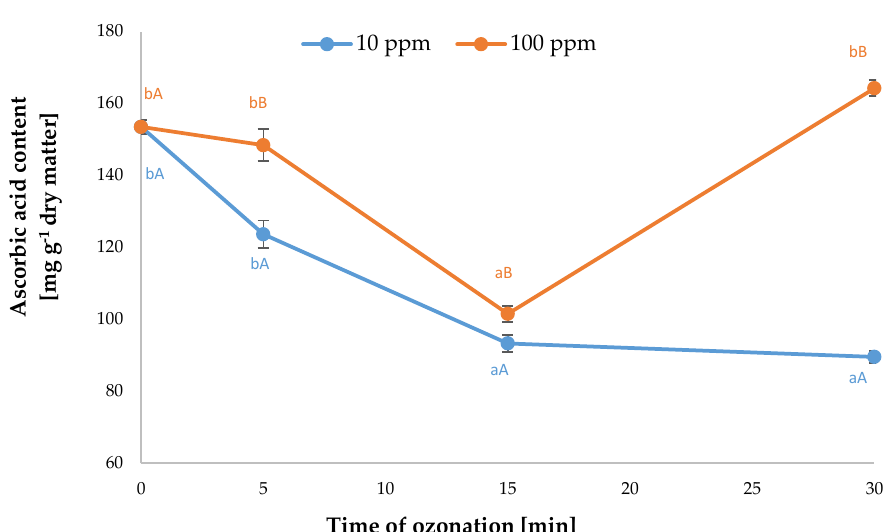
Figure 7. Total polyphenolic content in Rheum rhaponticum L. petioles, depending on the duration of ozone treatment (n = 3) . The differences in the results between the ozonation time for individual variants are marked with different small letters, and the difference between the measurement values for the tested variants is marked with different capital letters, p < 0.05.